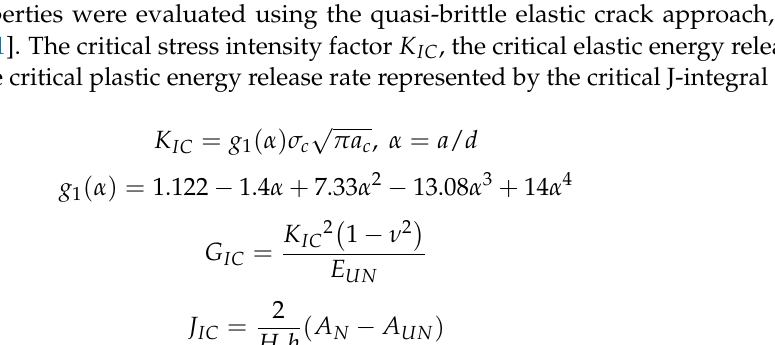
Figure 4. ( a ) Schematic and ( b ) testing setup of three-point bending fracture test.